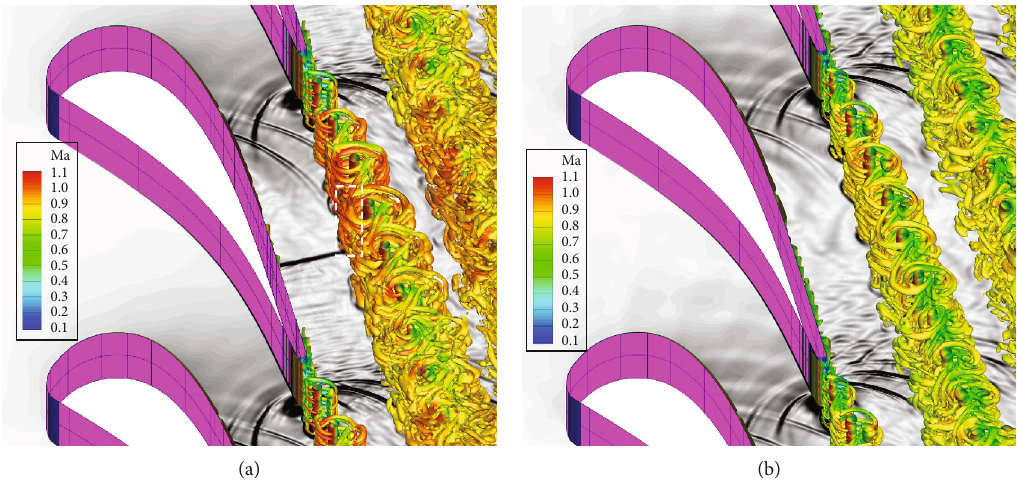
Figure 12: Three-dimensional development of wake vortex: (a) fl ow condition MUR235; (b) fl ow condition MUR129.